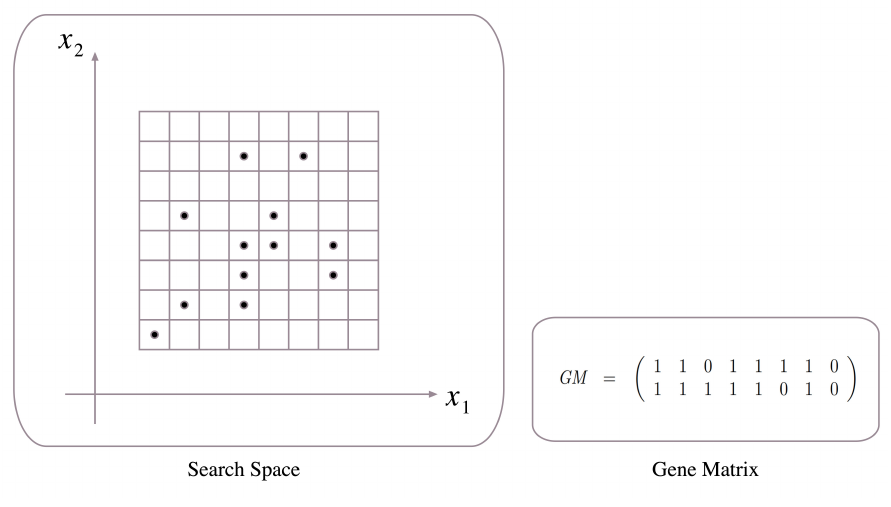
Figure 5. An Example of the GM in two